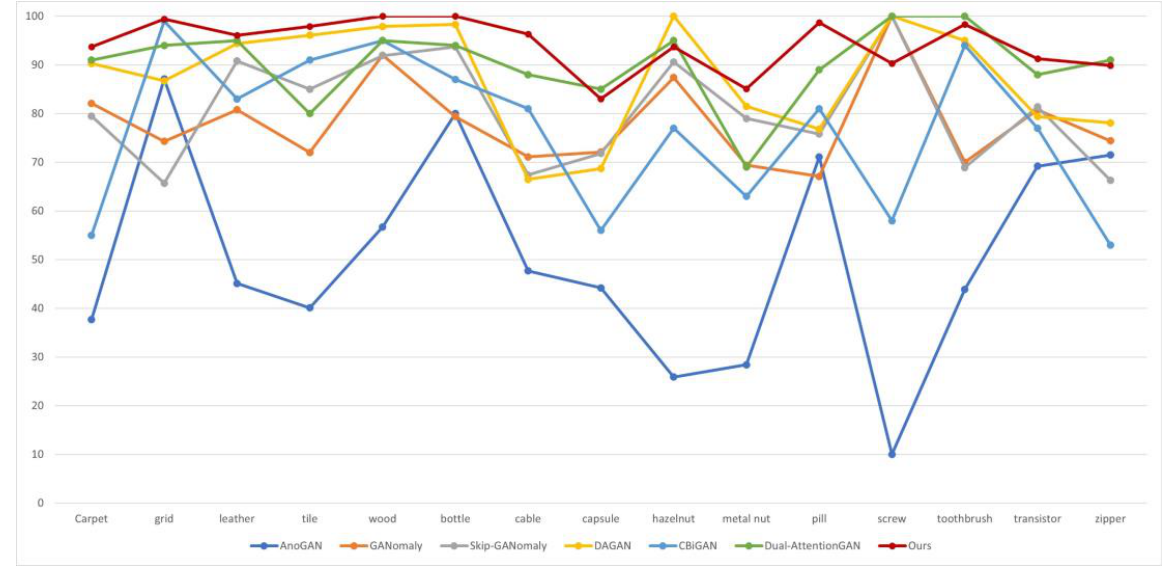
Figure 6. Visualization of the AUC values of the method we proposed and the other six methods.